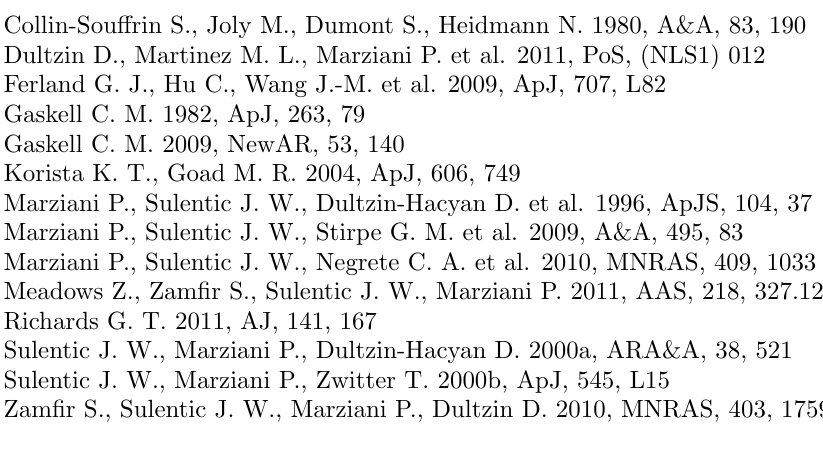
Fig. 2. Relationship between the centroid c ( 1 and vs. M BH (right). Large (cid:12)lled circles identify Pop. B sources; grey squares Pop. A sources. Typical error bars (at a 2 (cid:27) con(cid:12)dence level) are shown. In the right panel, the solid line is the best least-square (cid:12)t for all sources; the dashed line { for Pop. B objects